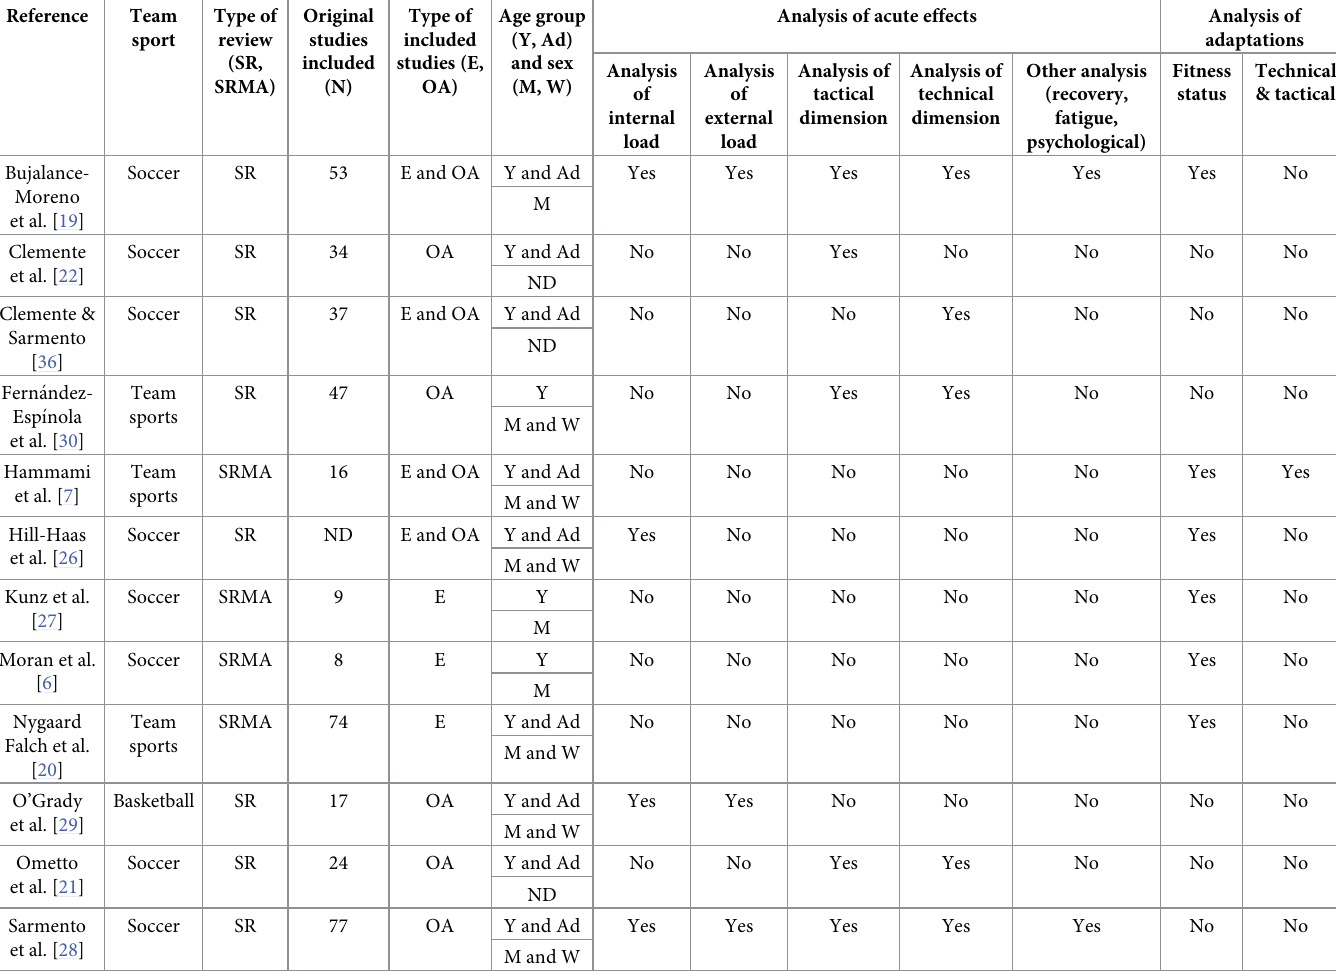
Table 1. Summary of SR and SRMA